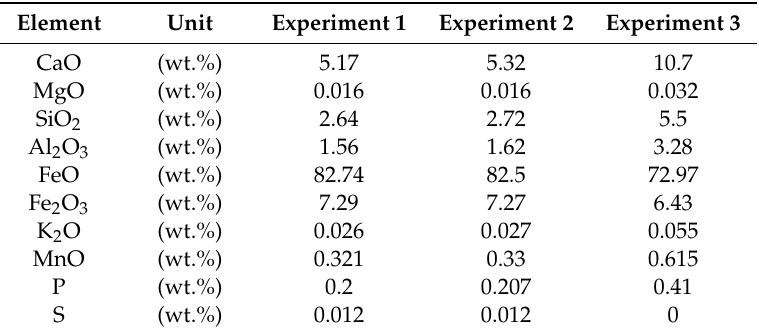
Table 10. Chemical composition of slags of Experiments 1, 2 and